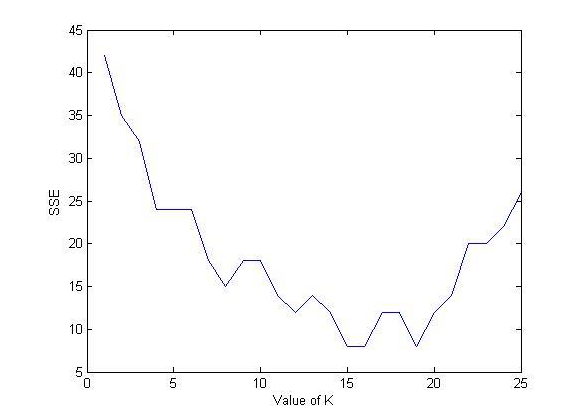
Figure 6. Two-fold cross-validation error rate for K-NN